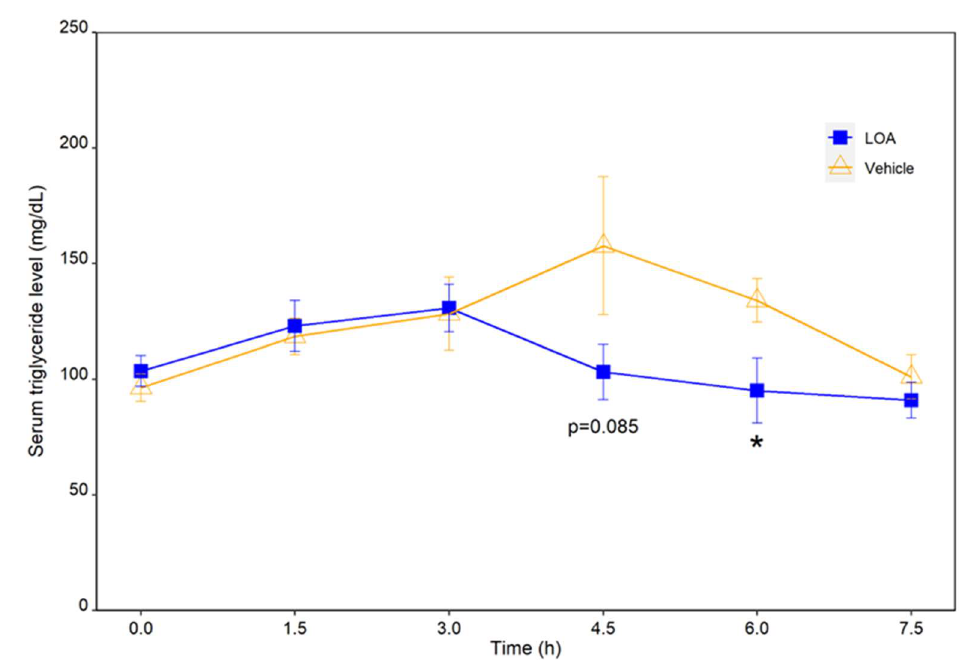
Figure 6. Post-prandial TAG responses of rats administrated with a mixture of linoleic acid and oleic acid (LOA) at a dose of 0.46 mg/kg and 0.72 mg/kg body weight or the vehicle and challenged with an HFD. * p < 0.05.